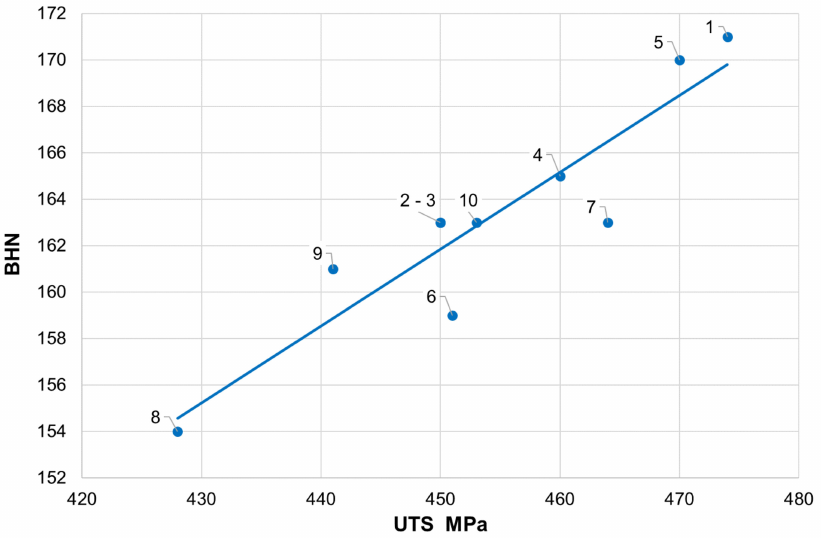
Figure 2. Ultimate tensile strength (UTS) and Brinell hardness number (BHN) in individual